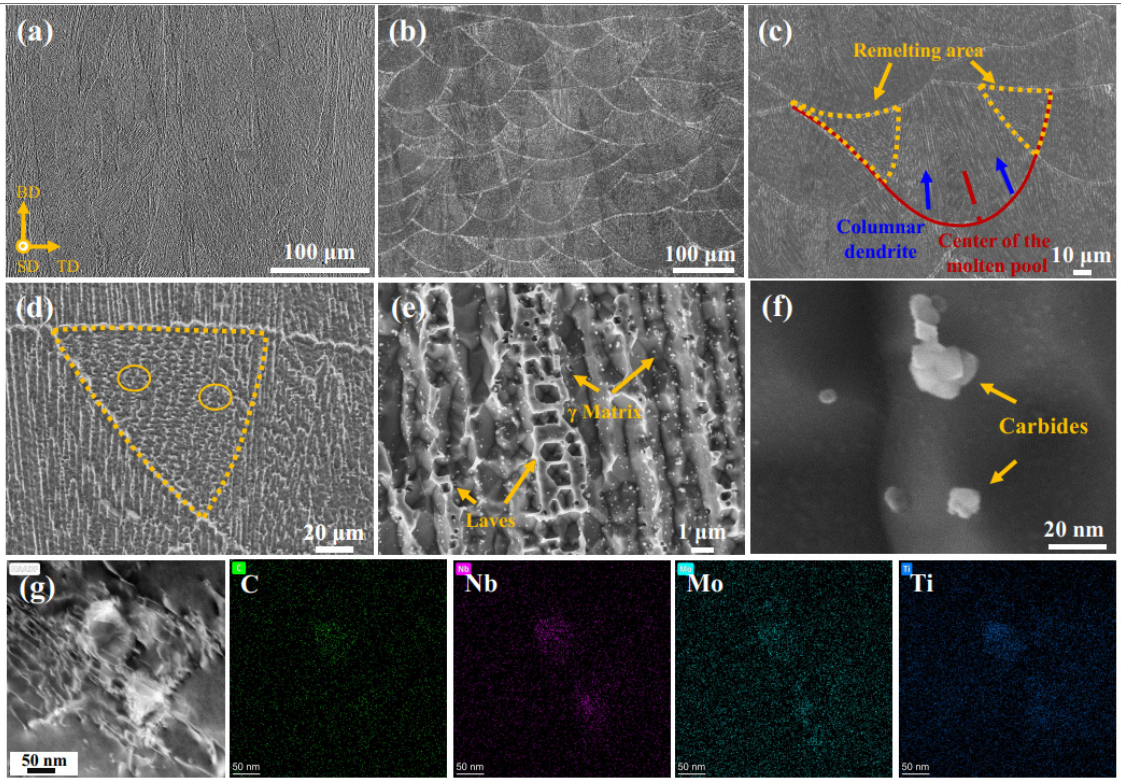
Figure 2. Microstructure analyses: ( a ) BSE and ( b – f ) SEM micrographs. ( g ) The EDS analysis for carbides.